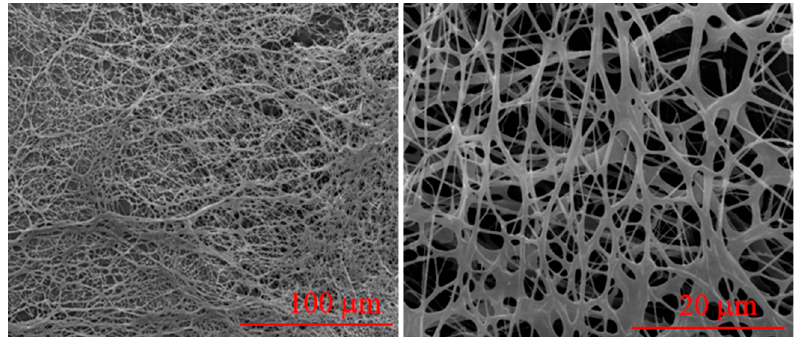
Figure 4. Environmental scanning electron microscope (ESEM) image of the 0.1 wt % PAANM solution.